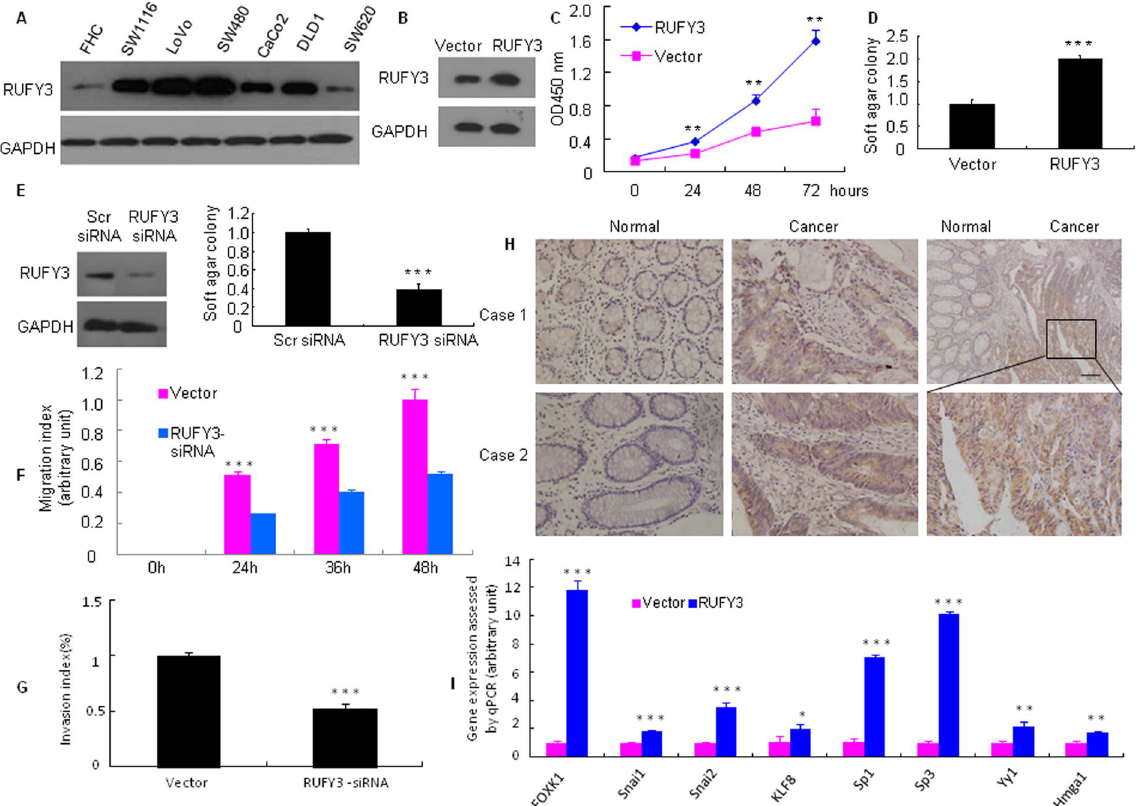
Figure 1. RUFY3 is overexpressed in human CRC cells. ( A ) RUFY3 expression was detected by western blot with GAPDH used as the internal control. ( B , C ) The proliferation of pooled stable RUFY3 transfectants and vectors was evaluated using a WST-1 assay. ** P < 0.01. ( D , E ) Cells were transfected with RUFY3-siRNA or scr-siRNA (scramble siRNA) for 48 h, which was followed by western blot analysis. Vector and pooled stable RUFY3 transfectants, Scr siRNA and RUFY3 siRNA in LoVo cells and their corresponding control cells were plated in tissue culture dishes. Colonies containing > 50 cells were considered viable, and the results are presented as the means ± SD. *** P < 0.001. ( F ) Knockdown of RUFY3 led to a significantly slower migration at 24, 36, and 48 h after cells were infected with RUFY3 siRNA. *** P < 0.001. ( G ) Inhibition of RUFY3 led to a reduced invasive ability of LoVo cells. *** P < 0.001. ( H ) RUFY3 expression in normal and malignant human colorectal tissues was detected by IHC. Scale bars, 100 μ m. ( I ) Expression changes of 8 major oncogenes in pooled stable transfectants of Vector or RUFY3, as detected by qRT-PCR in LoVo cells. * P < 0.05, ** P < 0.01, and *** P < 0.001. All experiments were repeated at least twice. The full-length blots/gels are presented in Supplementary Figure